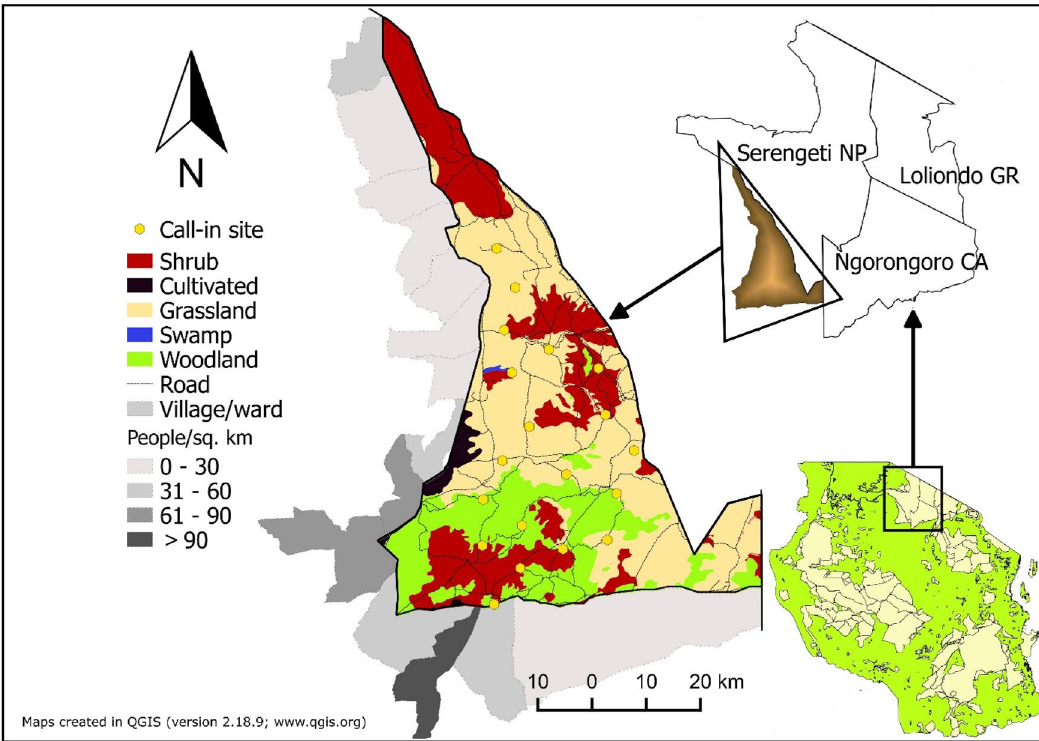
Figure 3. Locations of call-in sites used to estimate lion and spotted hyena abundance, Maswa Game Reserve, Tanzania, 2017. Beyond southern and western borders are the neighboring villages/wards. Light gray are less human populated villages/wards than darker